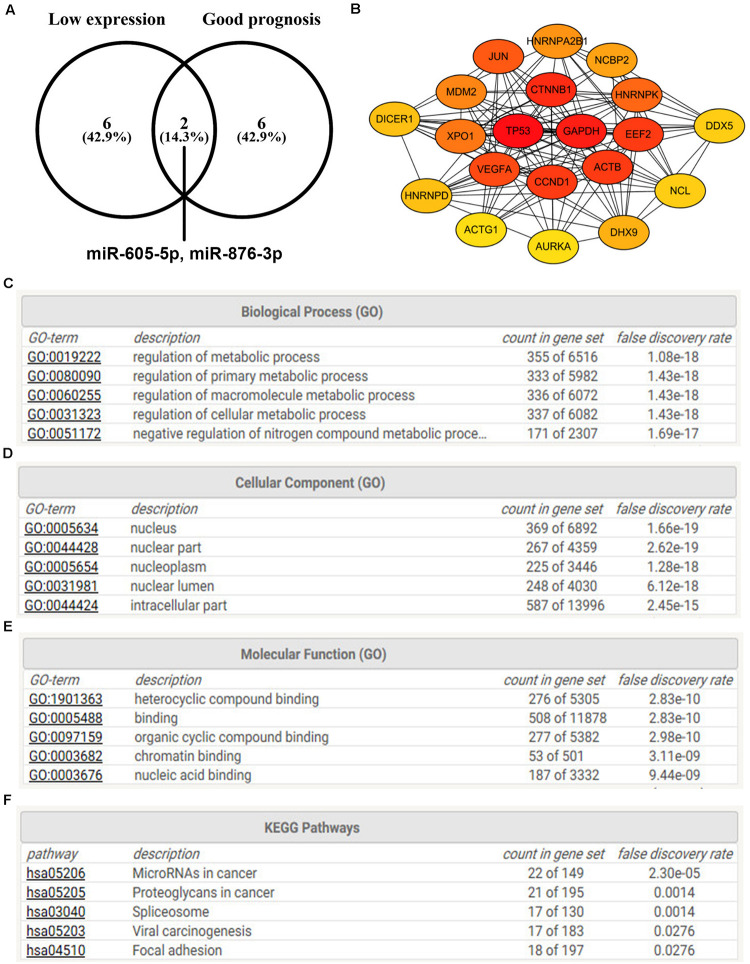
The protein–protein interaction (PPI), Gene Ontology (GO) functional annotation, and KEGG pathway enrichment analyses for target genes of miR-605-5p and miR-876-3p. (A) Identification of miR-605-5p and miR-876-3p as two most potential binding miRNAs of candidate circRNAs. (B) The PPI analysis for target genes of miR-605-5p and miR-876-3p. (C) The top 5 GO biological process items for target genes of miR-605-5p and miR-876-3p. (D) The top 5 GO cellular component items for target genes of miR-605-5p and miR-876-3p. (E) The top 5 GO molecular function items for target genes of miR-605-5p and miR-876-3p. (F) The top 5 KEGG pathways for target genes of miR-605-5p and miR-876-3p.